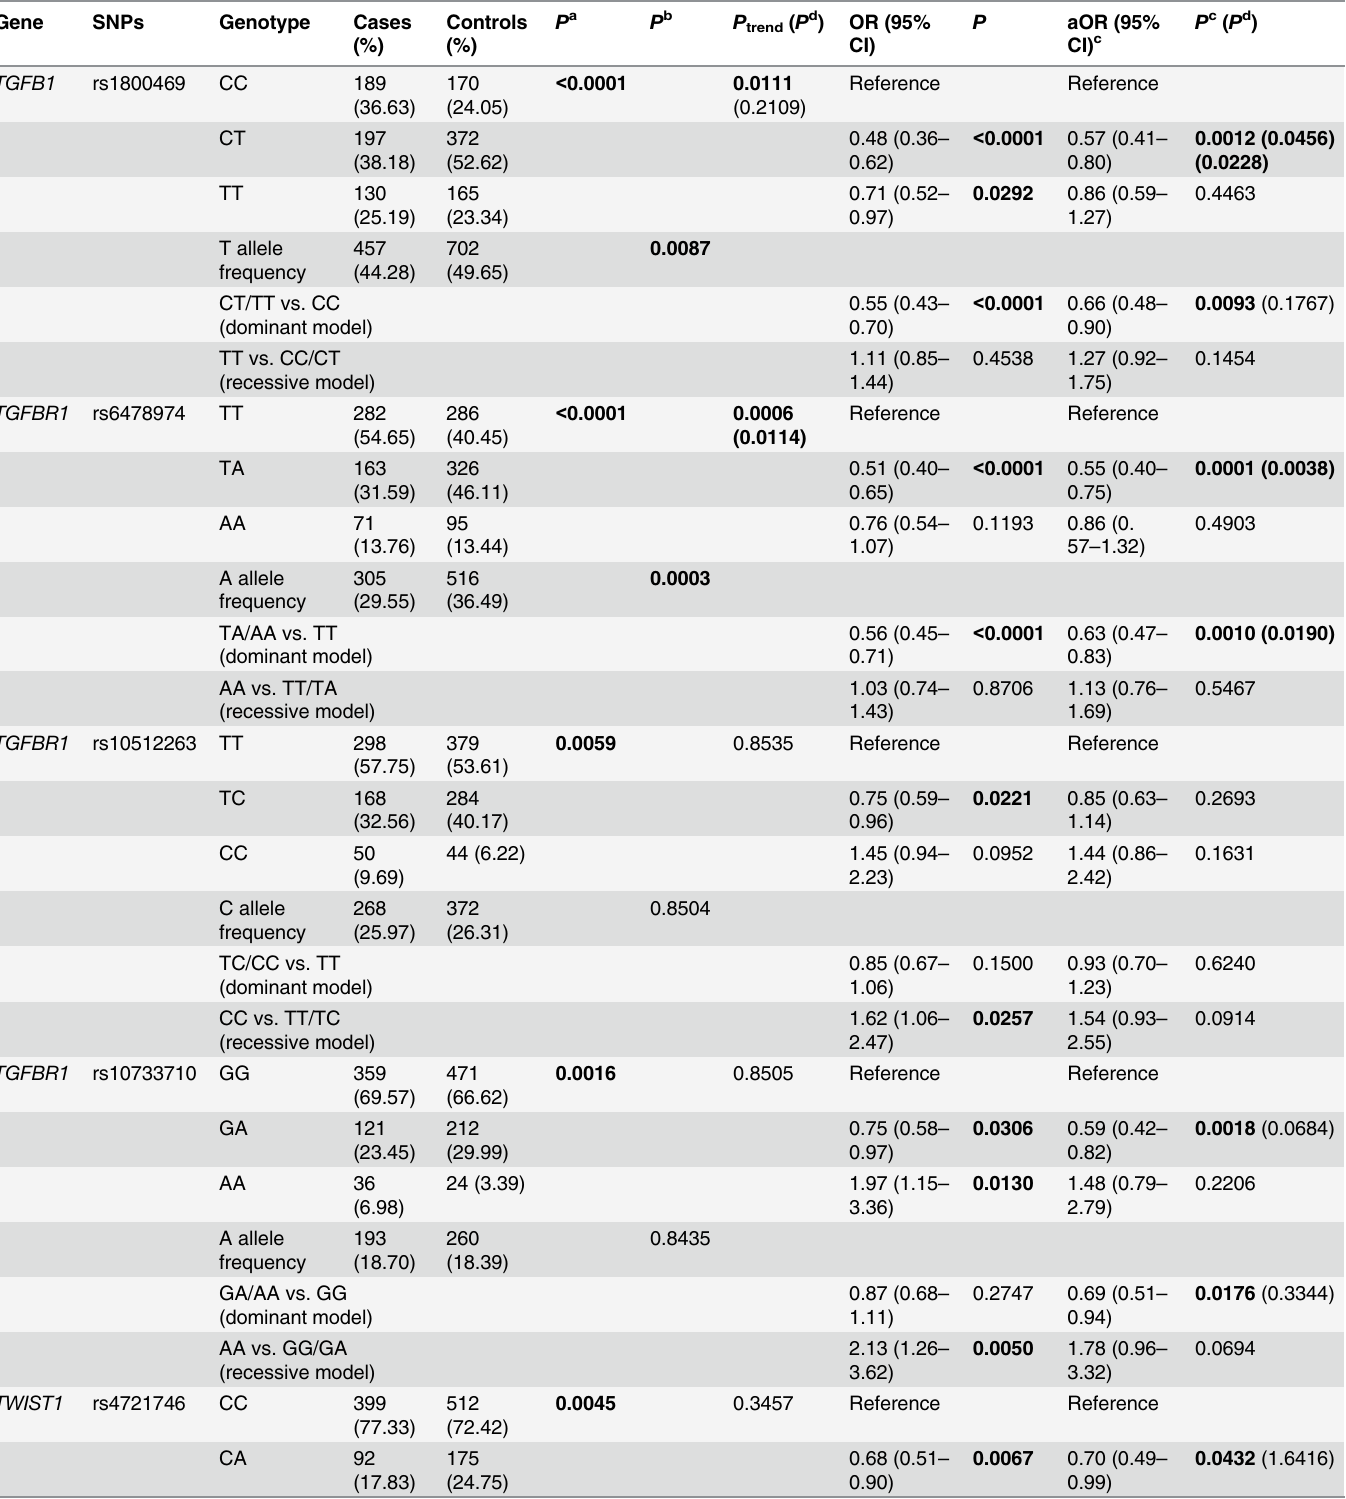
Table 1. Univariate and multivariate analysis of the association of candidate tSNPs with EC risk.